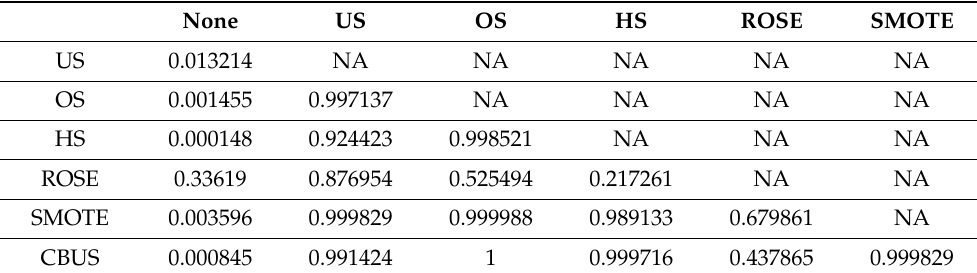
Table 13. Post hoc analysis using Nemenyi multiple comparison test for